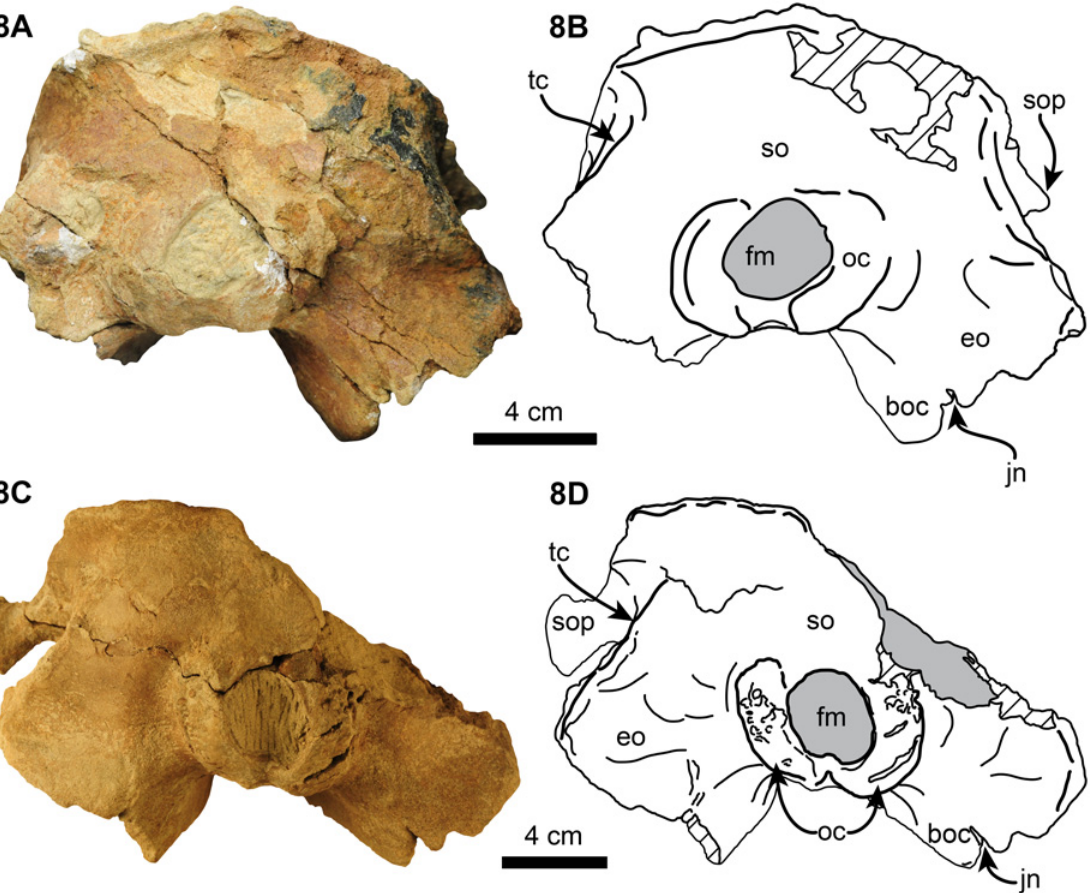
Fig 8. Posterior views of holotype (UF 280000), 7A-B, and referred specimen (UF 273554), 7CD, skulls of Nanokogia isthmia gen. et sp. nov. Abbreviations: boc, basioccipital crest; eo, exoccipital; fm, foramen magnum; jn, jugular notch; oc, occipital condyles; so, supraoccipital; sop, supraorbital process of frontal; tc, temporal crest. Gray shaded areas indicate sediment; diagonal lines denote broken